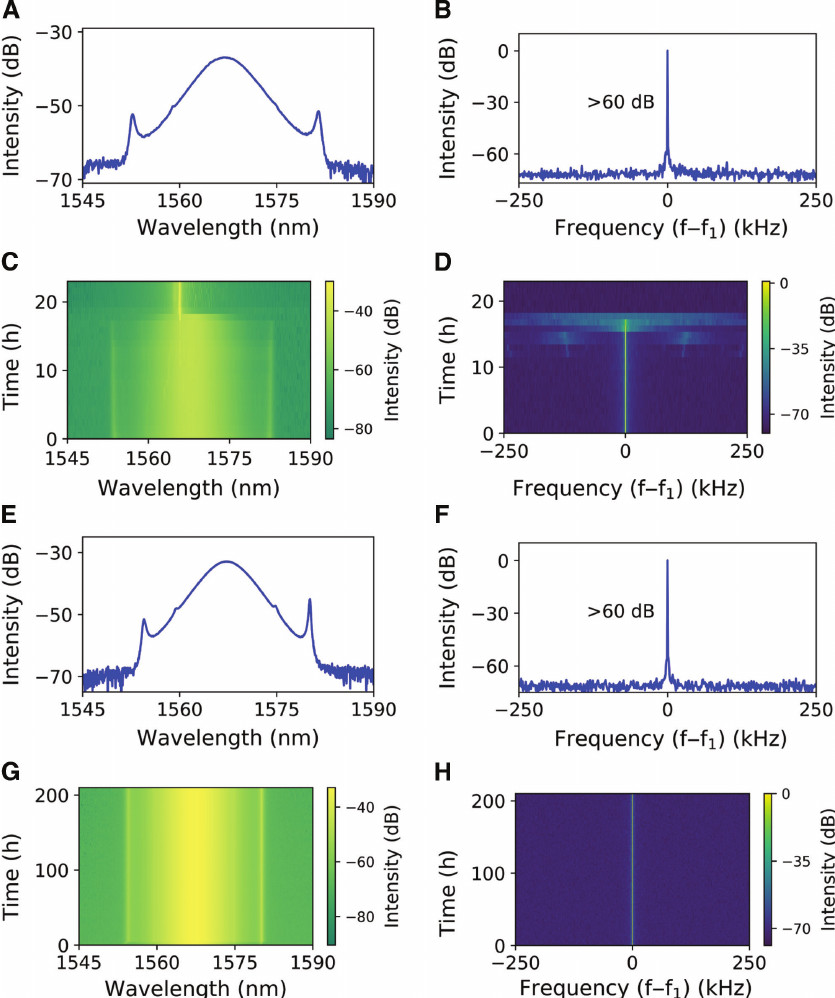
Figure 2: Mode-locking performance of the BP-SA. Mode-locked (A) spectrum and (B) RF spectrum from unprotected BP-SA laser under water immersion, output (C) optical spectra and (D) RF spectra across 23 h from unprotected BP-SA laser under water immersion, mode-locked (E) spectrum and (F) RF spectrum from parylene- C-encapsulated BP-SA laser under water immersion, and output (G) optical spectra and (H) RF spectra across 200 h from parylene-C- = 30.3 encapsulated BP-SA laser under water immersion. f 1